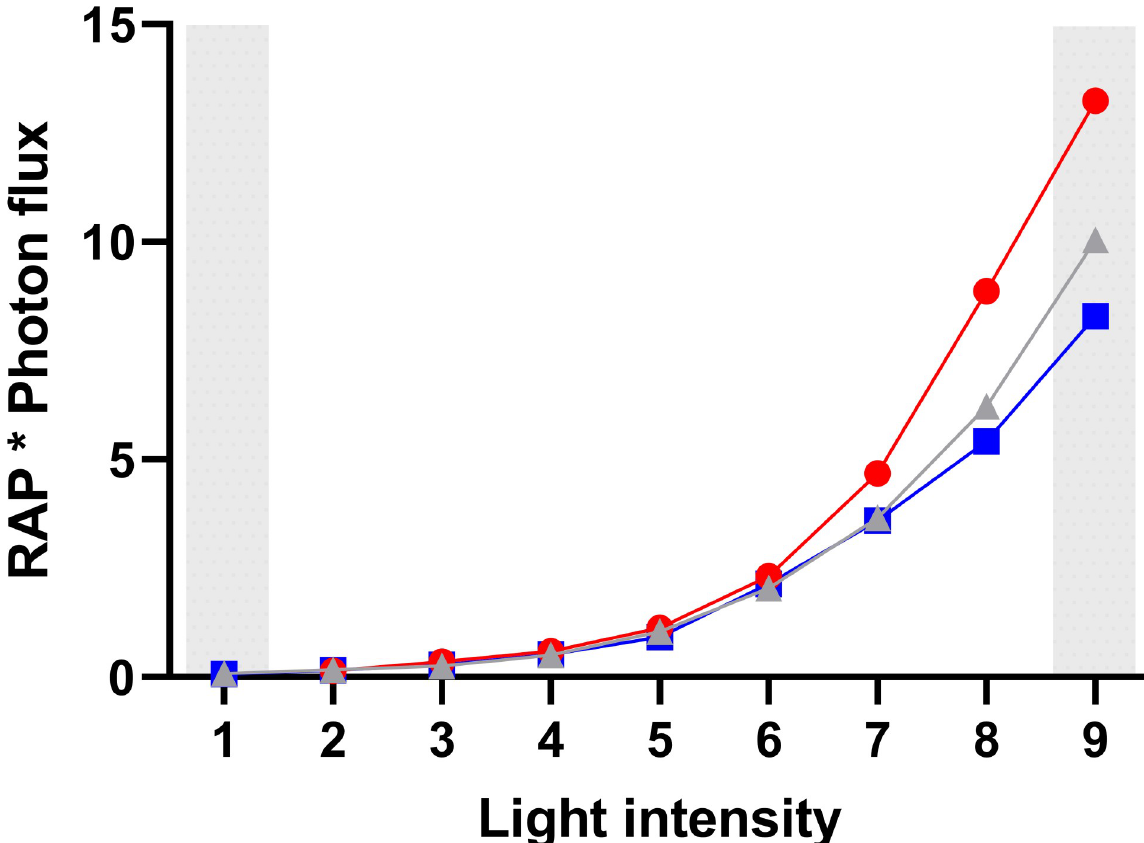
Fig 6. Relative number of photons reaching the retina when different light-emitting diode (LED) lights were employed. Grey area indicates dim night light treatment and daylight treatment in Experiment